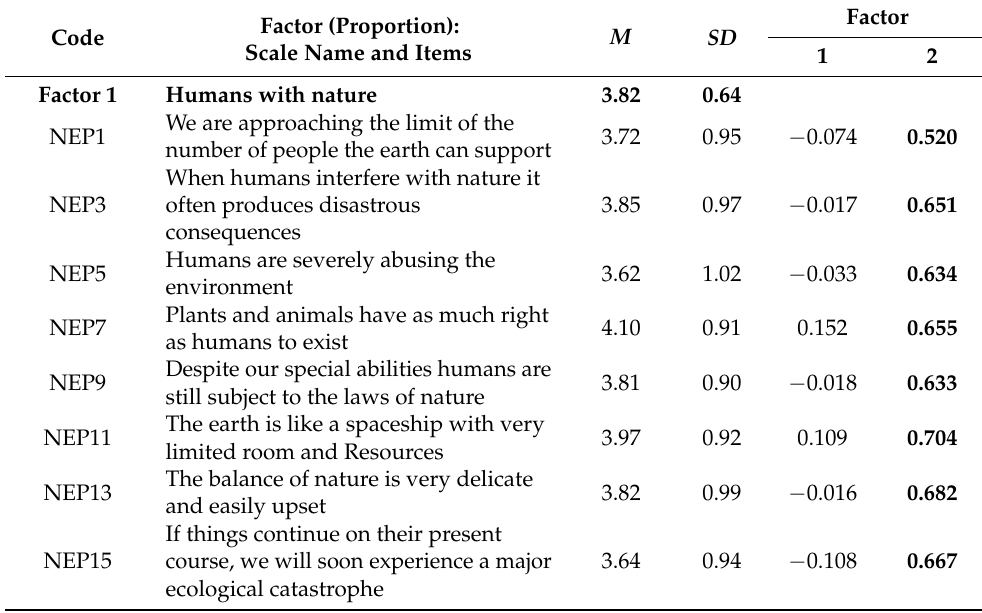
Table 5. Summary results of exploratory factor analysis for New Ecological Paradigm (aggregated data).